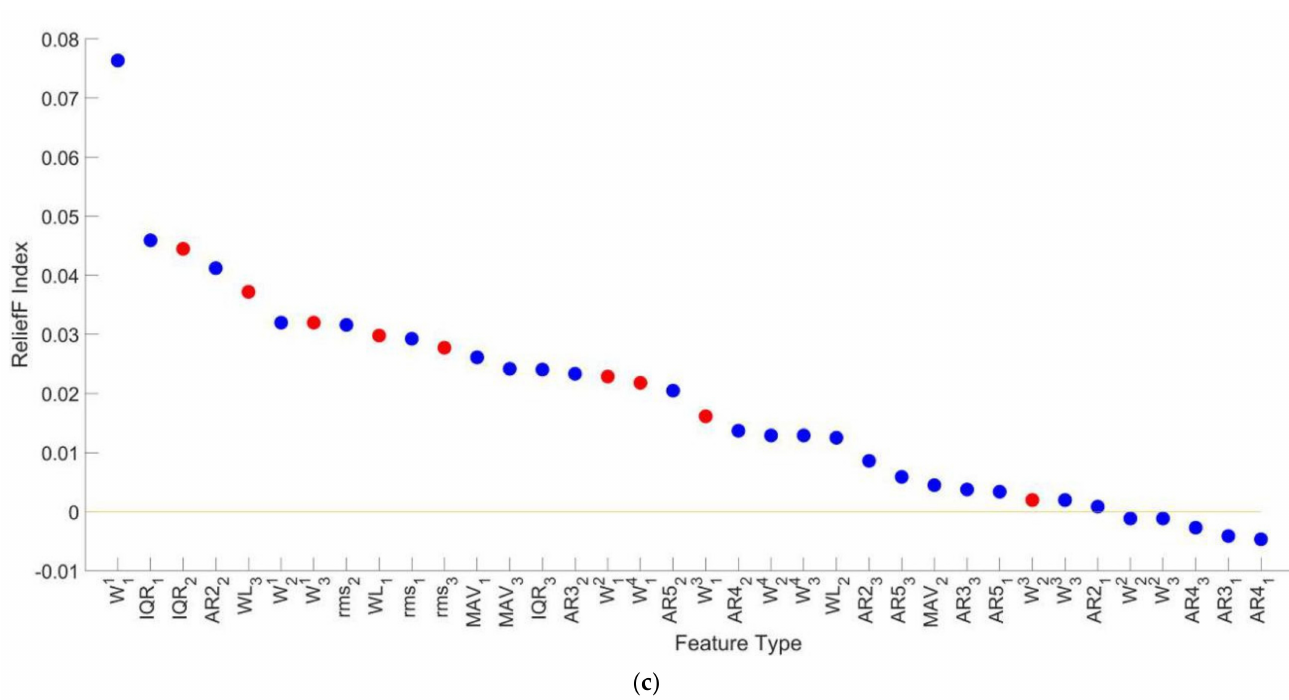
Figure 10. The ReliefF Index of all features in the fine feature sets and features (the red scatters) selected by the feature selection method when performing different motions. ( a ) STD, ( b ) ST and ( c ) Gait. The blue scatters represent features that are not selected by the feature selection method.